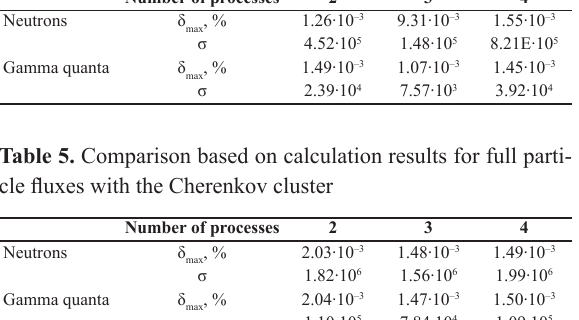
Table 4. Comparison based on calculation results for full parti- cle fluxes with the Basov cluster Number of processes